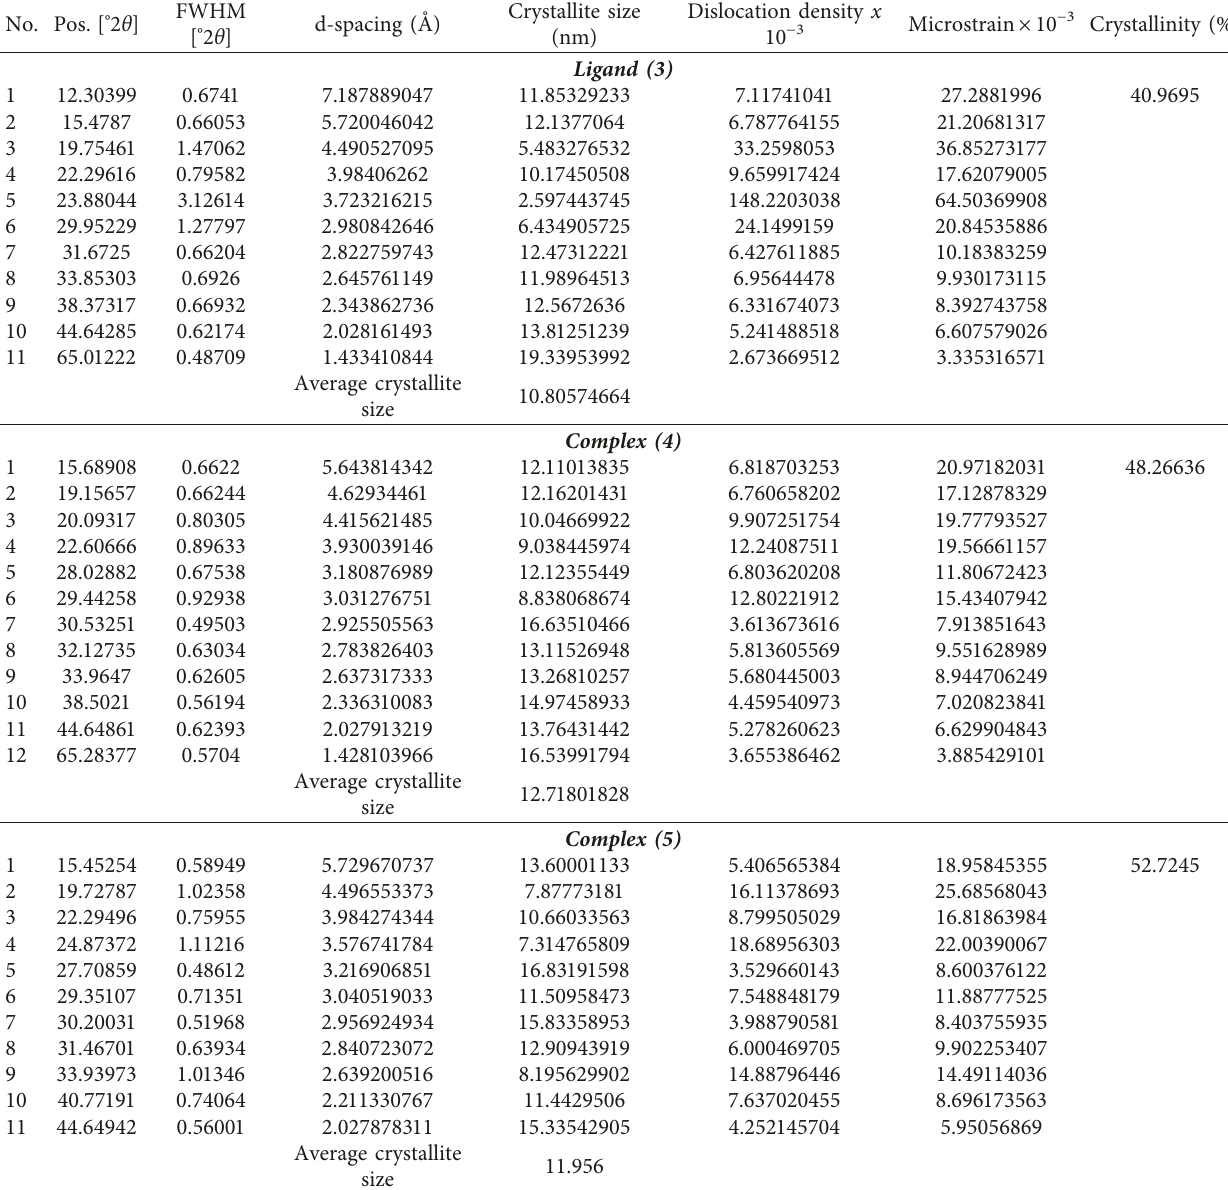
Table 2: Crystal data of ligand ( 3 ) and complexes ( 4) and ( 5